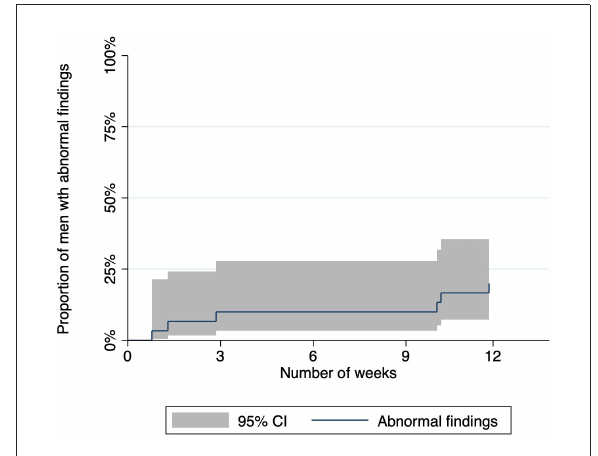
FIGURE1 Graph showing the proportion of men who reported abnormal findings and requested medical review during the 12-week study